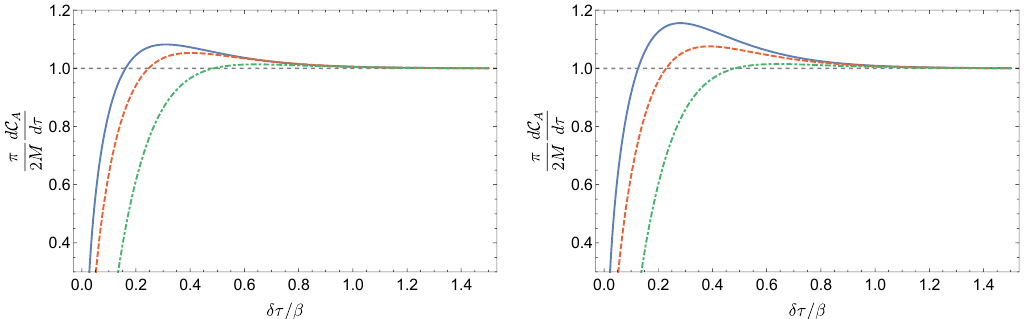
Figure 4 . Time derivative of complexity as a function of time for spherical ( k = +1, left) and planar ( k = 0, right) horizons with d = 4 boundary dimensions for various values of the horizon radius, i.e., r h =L = 1 (blue), r h =L = 1 : 5 (dashed red) and r h =L = 3 : 5 (dot-dashed green). We present the plots as a function of (cid:14)(cid:28) = (cid:28) (cid:0) (cid:28) c to allow for a meaningful comparison between the di(cid:11)erent cases. We stress again that each of the curves has a di(cid:11)erent value of (cid:28) c | see (cid:12)gure